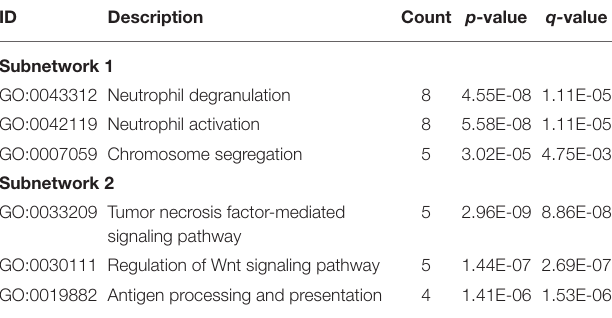
TABLE 2 | Representative GO results of two